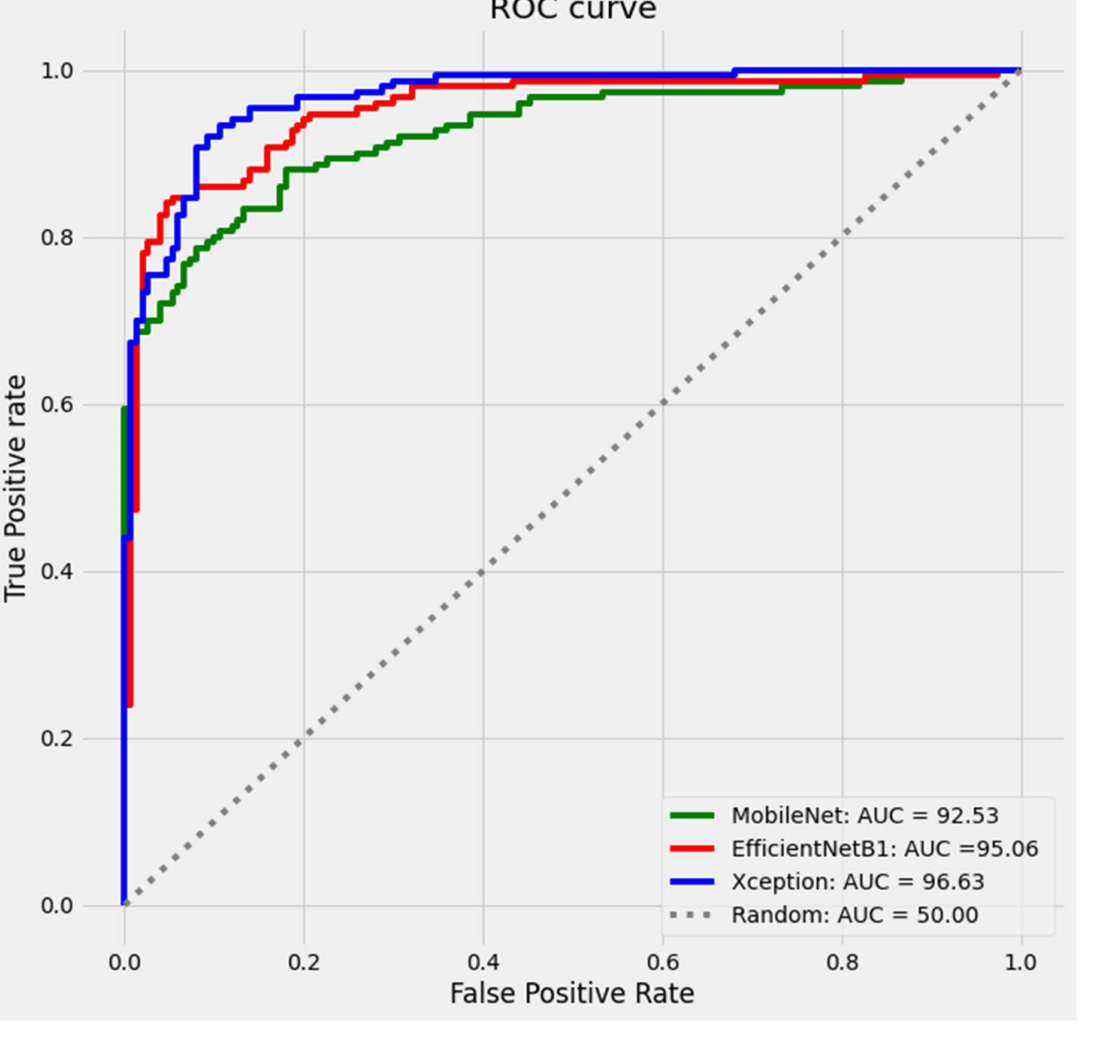
Figure 11. ROC curves of the three